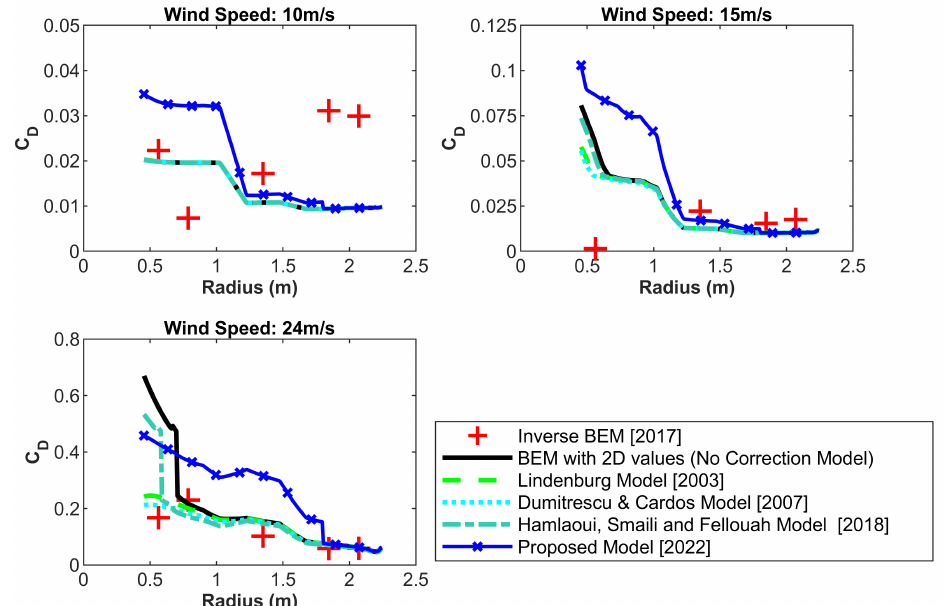
Figure 13. Contrast of evaluated C D throughout the blade length from BEM analysis without and with different correction models for stall delay and Inverse BEM method for MEXICO